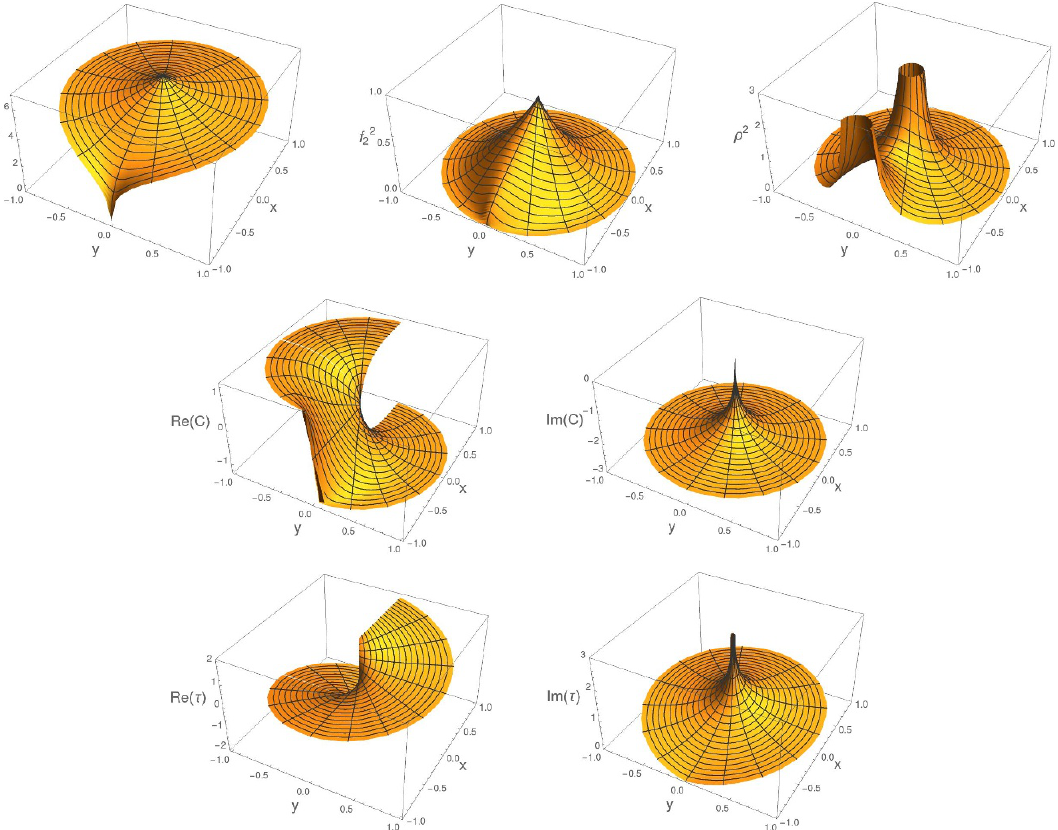
Figure 5. Plots of the supergravity (cid:12)elds for the I (cid:6) NS5-branes and a puncture with (cid:0) T j monodromy, for j = 4 and N = 5. The metric and complex 2-form in (2.2) are parametrized as ds 2 = f 2 u = x (cid:0) iy . The plots in the (cid:12)rst row show the metric functions, the plots in the second row show the real and imaginary part of C , and the last two show the real and imaginary parts of (cid:28) . The metric functions are single-valued and positive in the interior of the disc. At the boundary the S 2 collapses, f 2 ! 0, closing o(cid:11) the internal space smoothly. At the pole the behavior is as expected 2 for a 5-brane (as discussed in [34]). At the puncture, f 2 as j u j (cid:0) 1 ln j u j . C and (cid:28) transform as desired across the branch cut. The imaginary part of C is